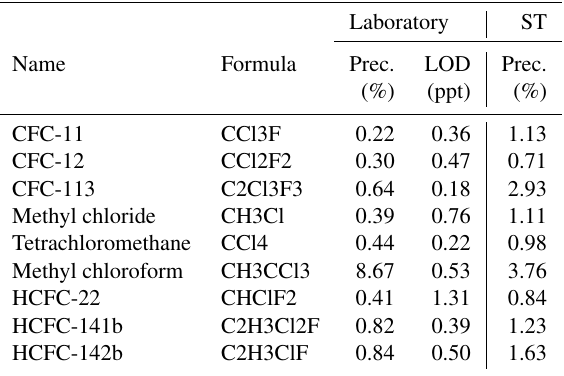
Table 1. Chlorinated species measured with the GhOST-MS. The precisions and limit of detections (LODs) of GhOST were deter- mined in the laboratory shortly before the SouthTRAC (ST) cam- paign, and mean precision was calculated during the flights. Laboratory